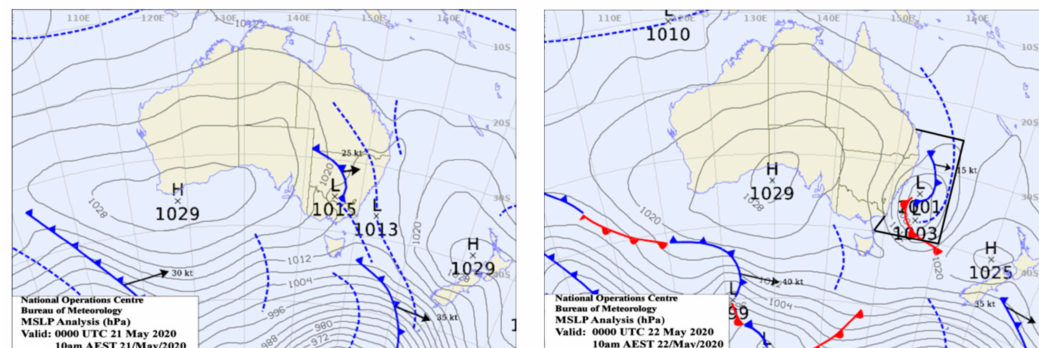
Figure 1. An example of an Australian ECL pressure system. The MSLP analyses are from the Australian Bureau of Meteorology and are valid at: 00 UTC 21 May 2020 ( left panel ) and 00 UTC 22 May 2020 ( right panel ). The study area for both the ECL database [10] and this updated study is the area bounded by the black lines ( right panel